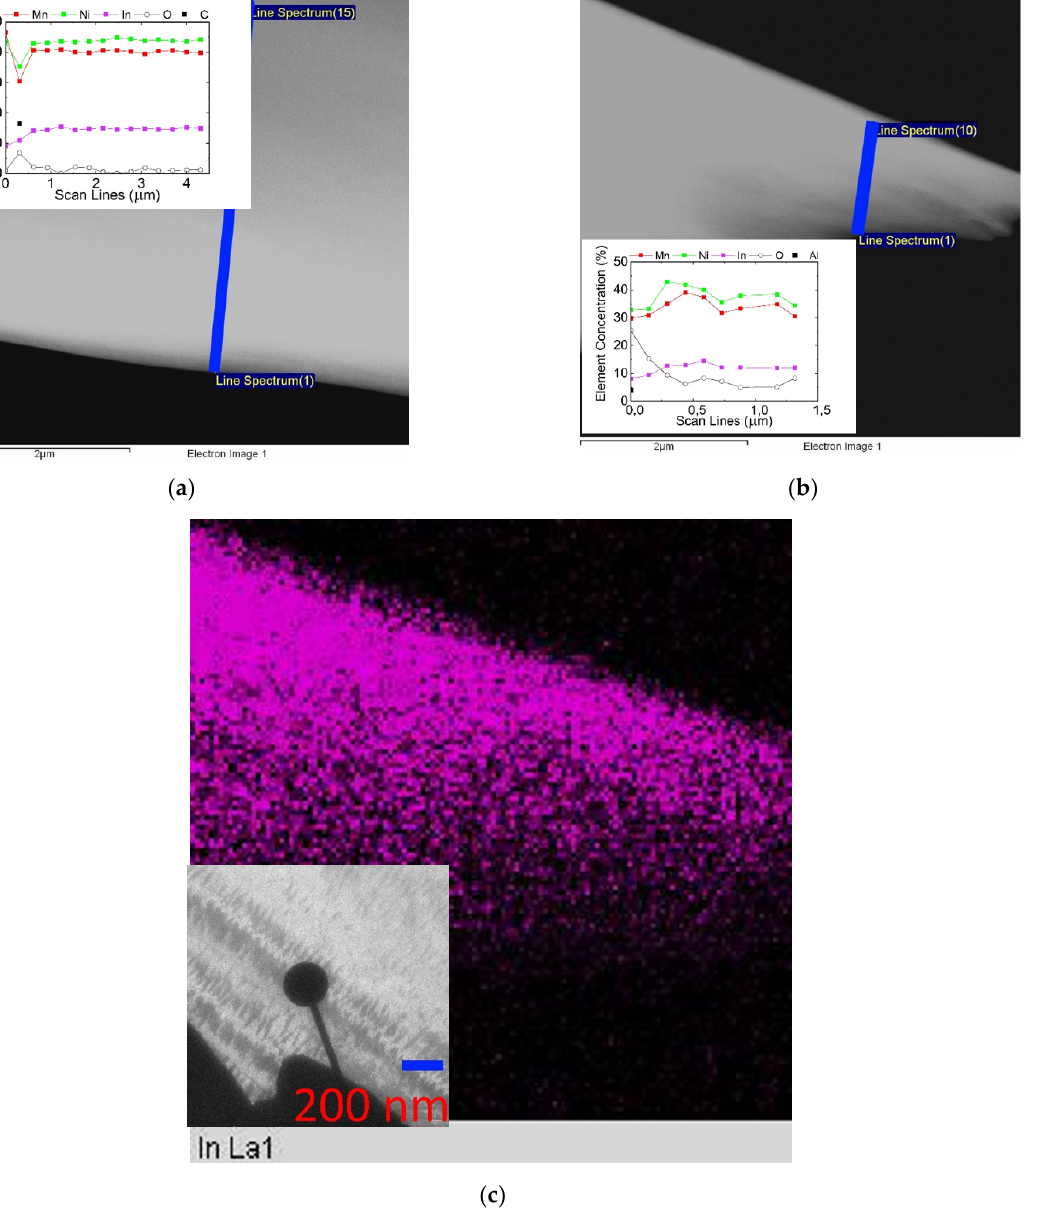
Figure 10. STEM images of local content of the elements O, In, Mn, Ni (on the graphs from bottom to top) along the scanning line with a large step ( a ) and a smaller step ( b ). The arrows indicate the scan lines. Distribution of indium ( c ) in the area circled in ( b ).